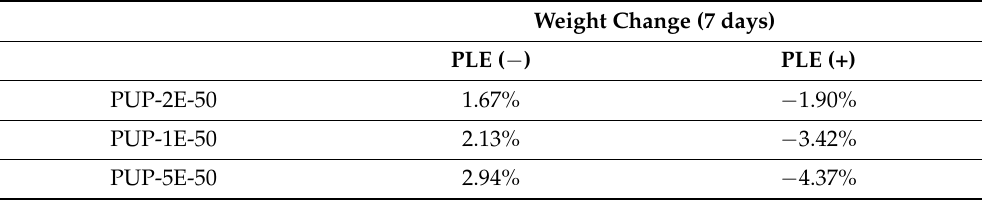
Table 4. Weight change after 7 days in presence (PLE(+)) and in absence (PLE( − )) of the esterase.